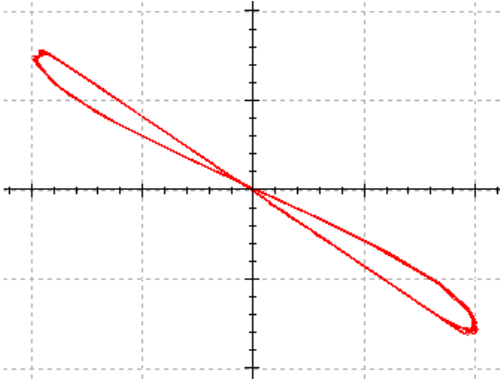
Figure 2: Flux-controlled memristors